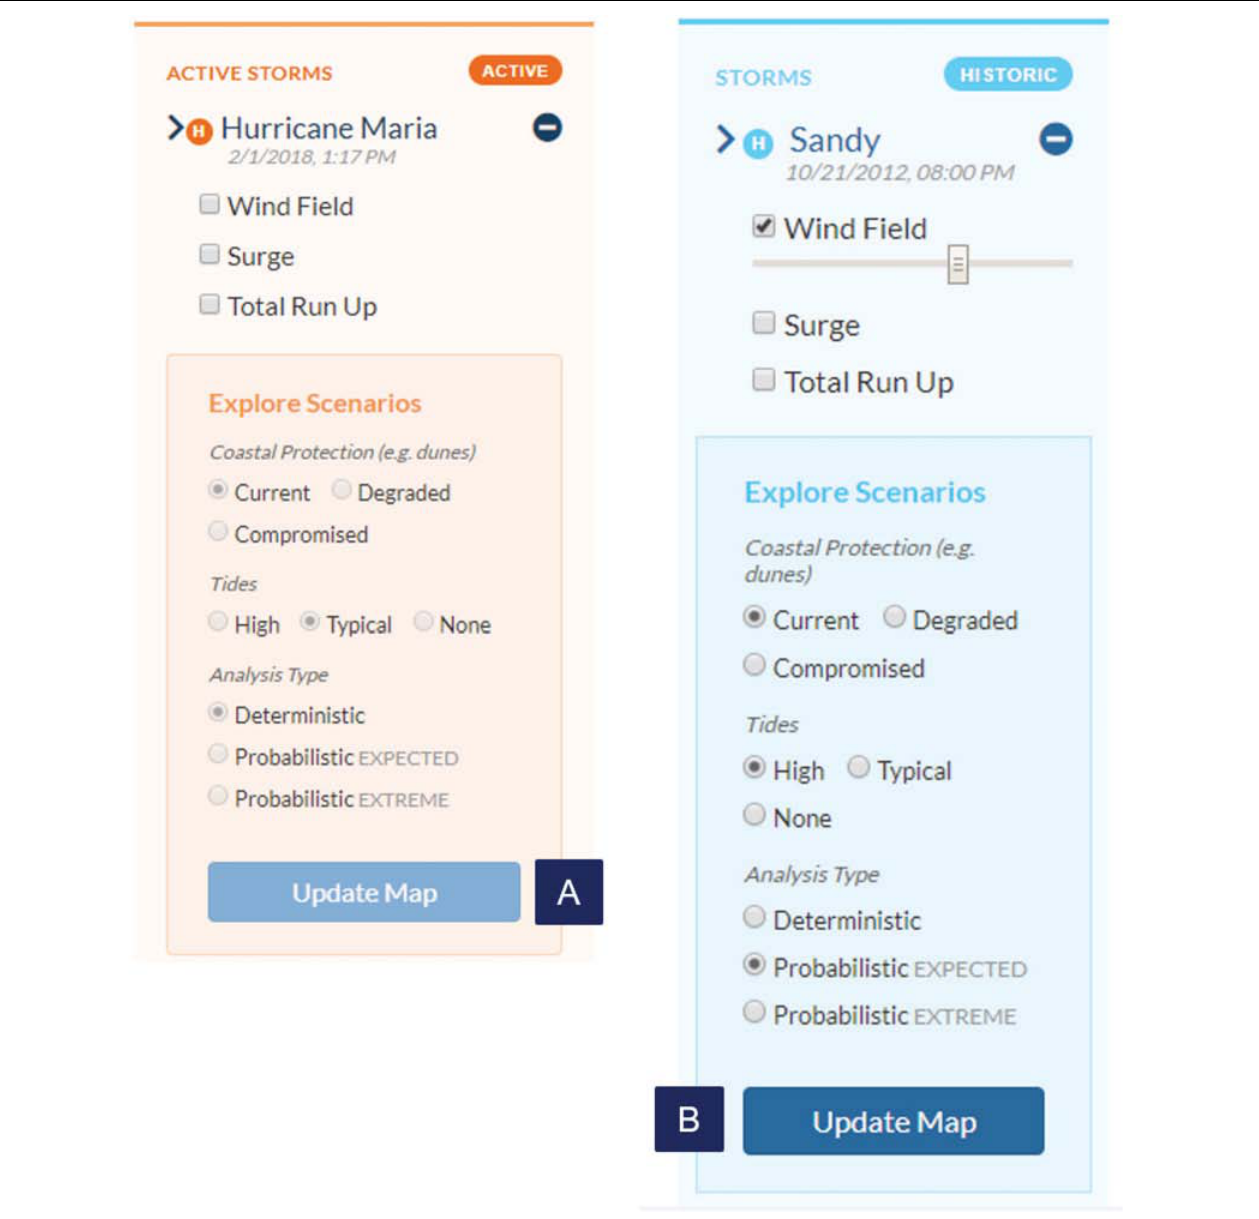
FIGURE 5 | Display option available when clicking on a preloaded Active Storm (A) or Historic Storm (B) Simulation result. Note in (B) that the selection of any hazard output activates a slider bar that can be used to adjust the transparency of the output layer on the